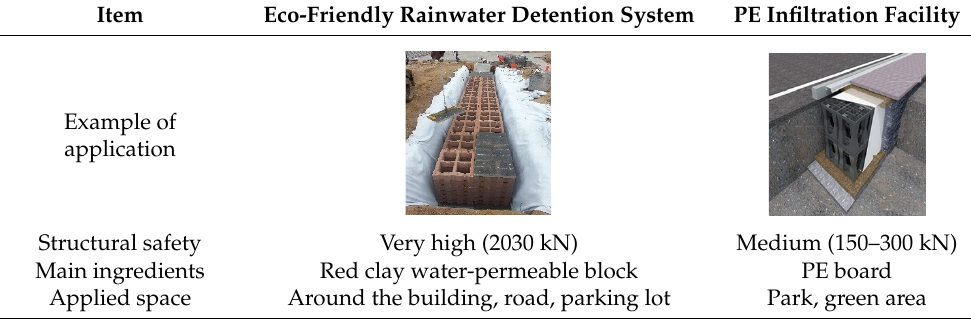
Table 1. Comparison of eco-friendly rainwater detention system with PE infiltration facility.